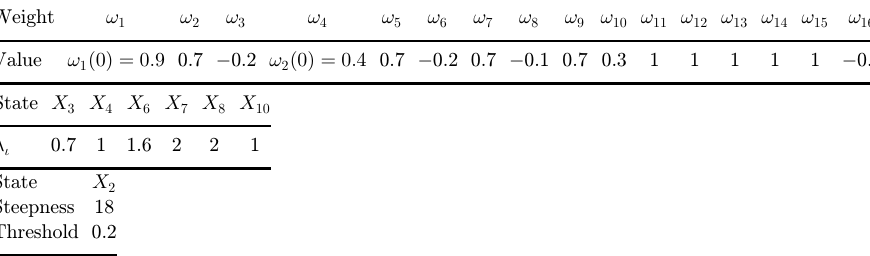
Table 4. Connection weights for the example simulation (Scenario 3).